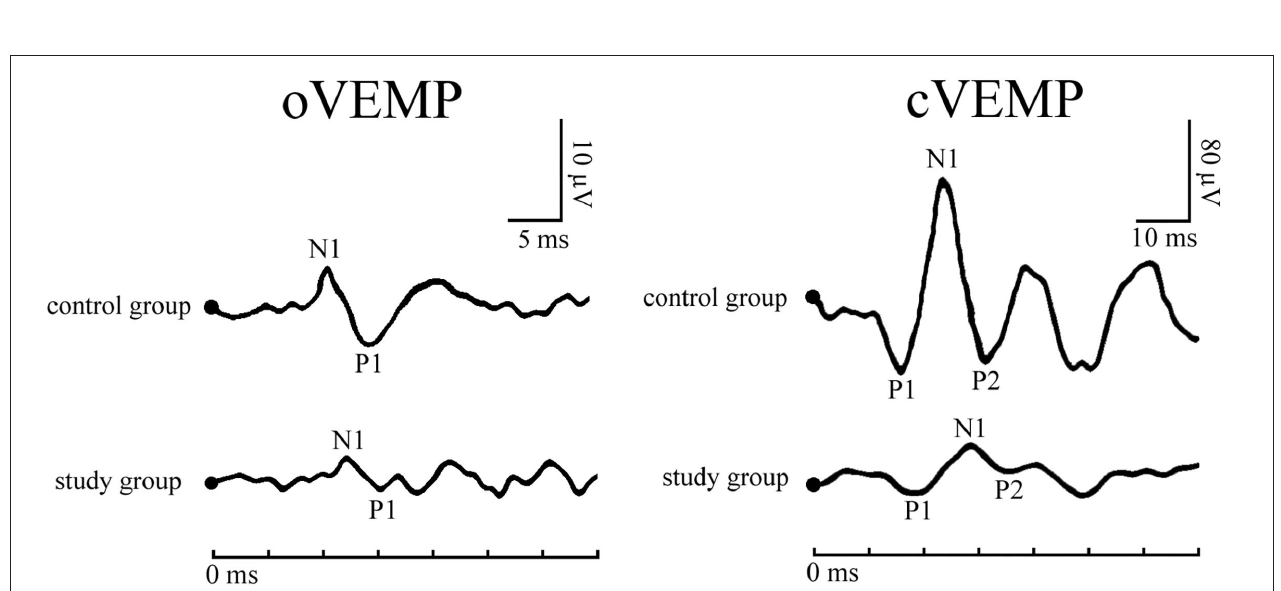
FIGURE 1 | Typical vestibular-evoked myogenic potentials (VEMPs) waveforms of a patient with obstructive sleep apnea (OSA) and a healthy subject.